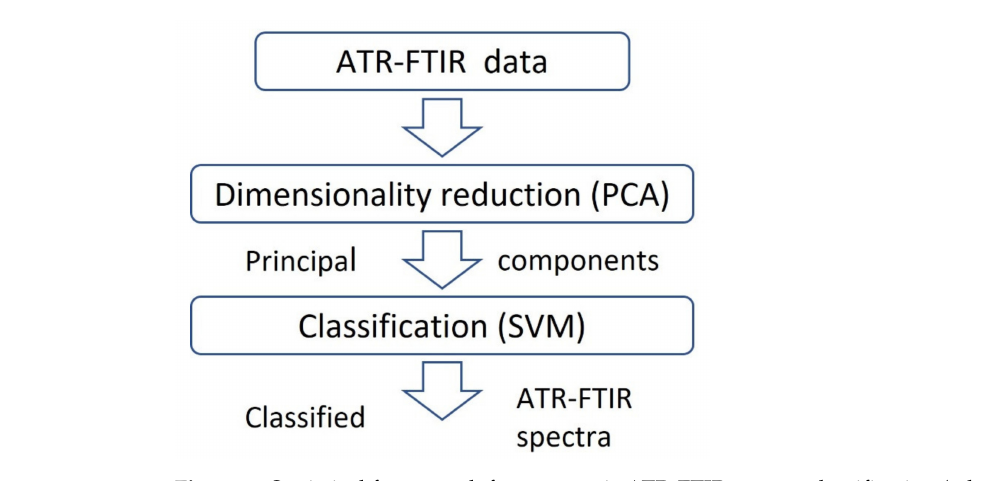
Figure 3. Statistical framework for automatic ATR-FTIR spectra classification (adapted from [24]).